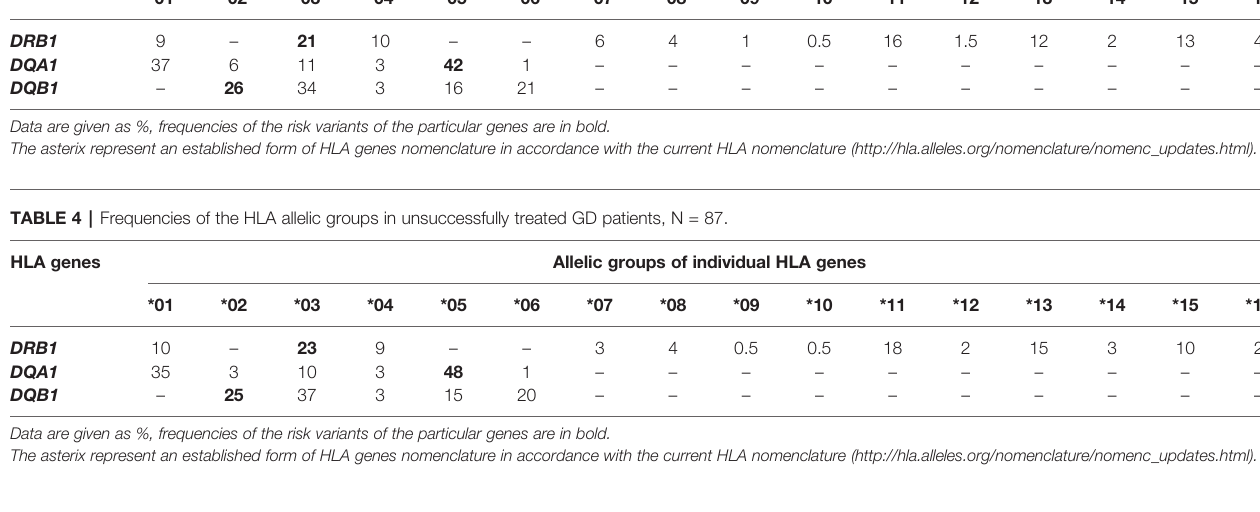
TABLE 5 | Frequencies of the HLA allelic groups in successfully treated GD patients, N = 26. HLA genes